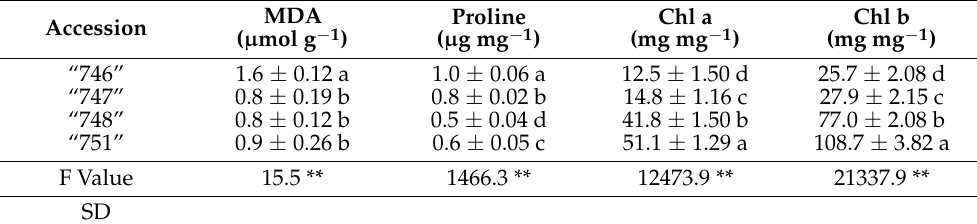
Table 6. Mean effect of the squash germplasm accession on the content of malondialdehyde (MDA), free proline and chlorophyll a and b (mean ± SD), regardless of the salinity level (NaCl concentration).